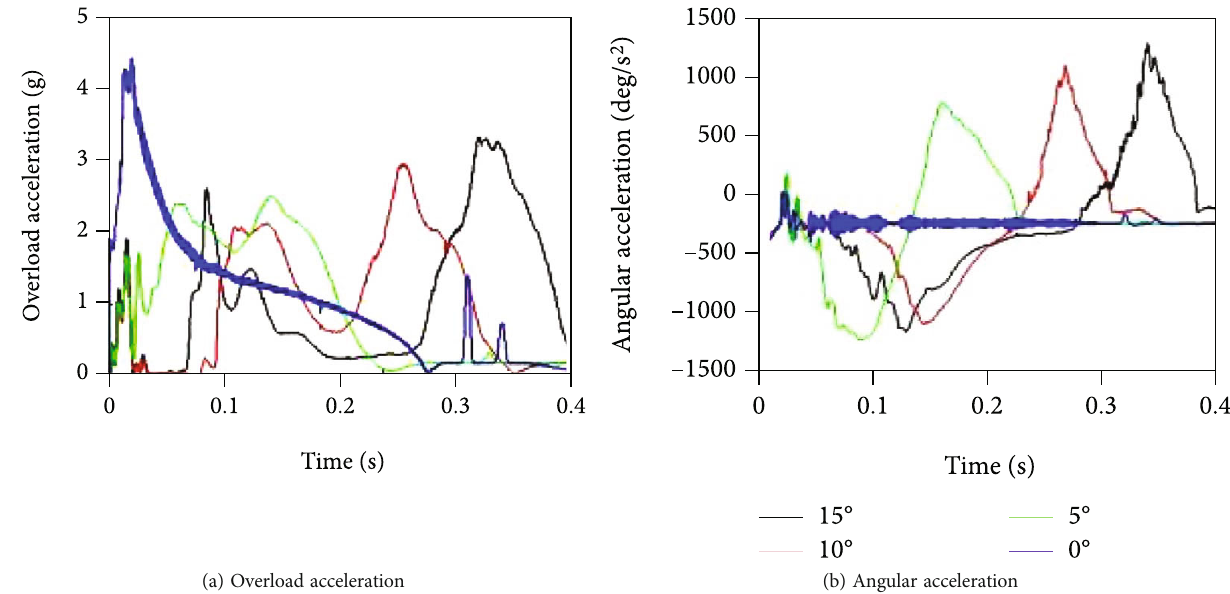
Figure 23: Acceleration vs. time curve under di ff erent